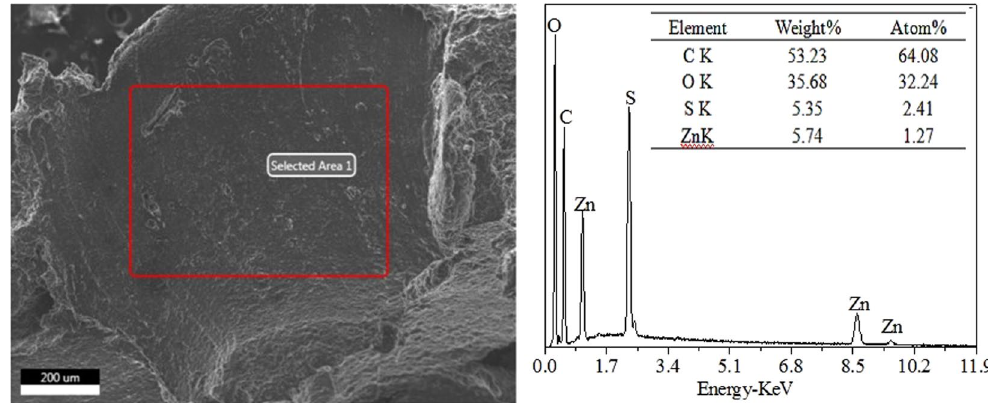
Figure 4. SEM-EDS of MHCO/GPTMS-ZnO composites.